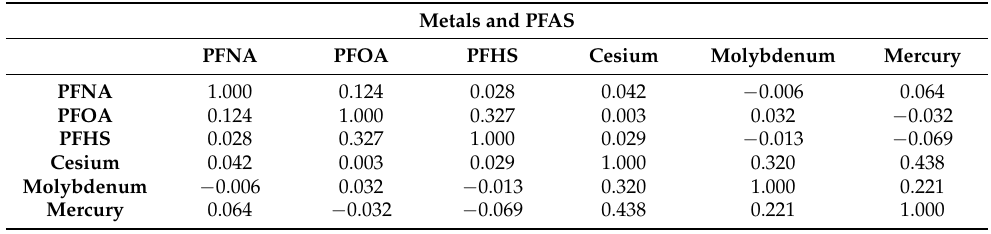
Table 4. Correlation between metals and PFAS